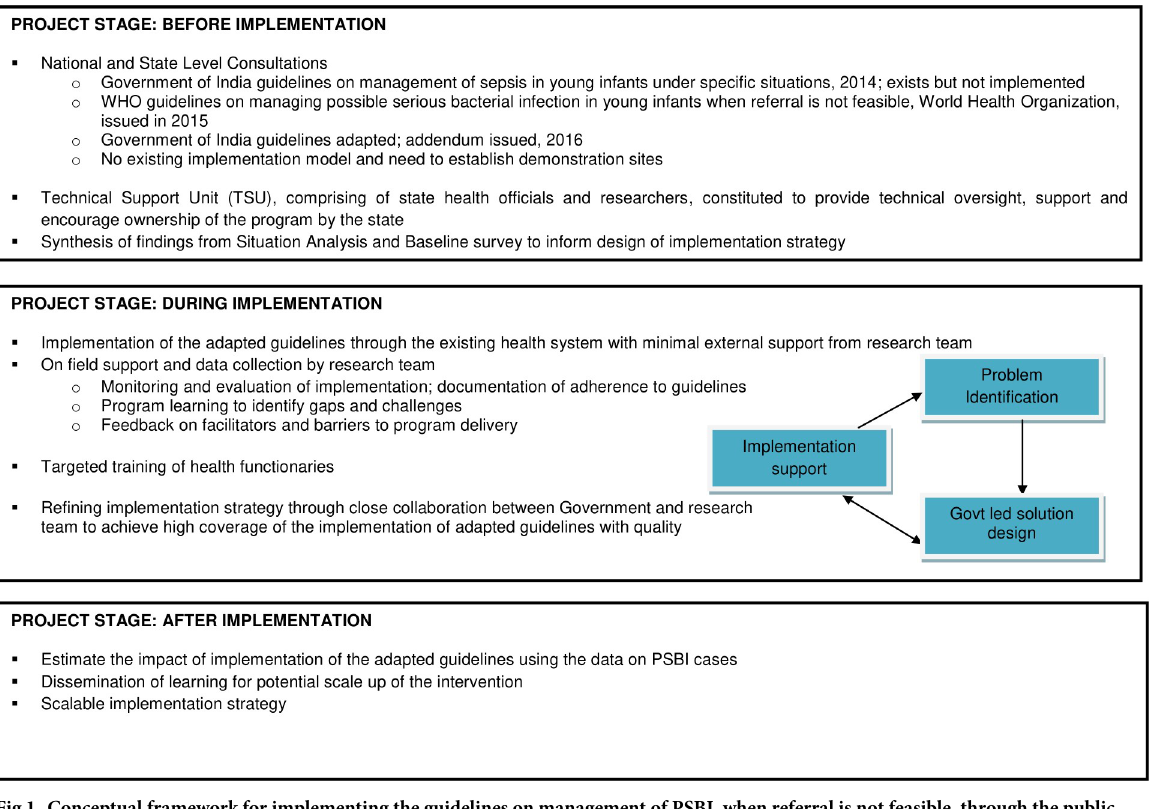
PLOS ONE | https://doi.org/10.1371/journal.pone.0243724 December22,